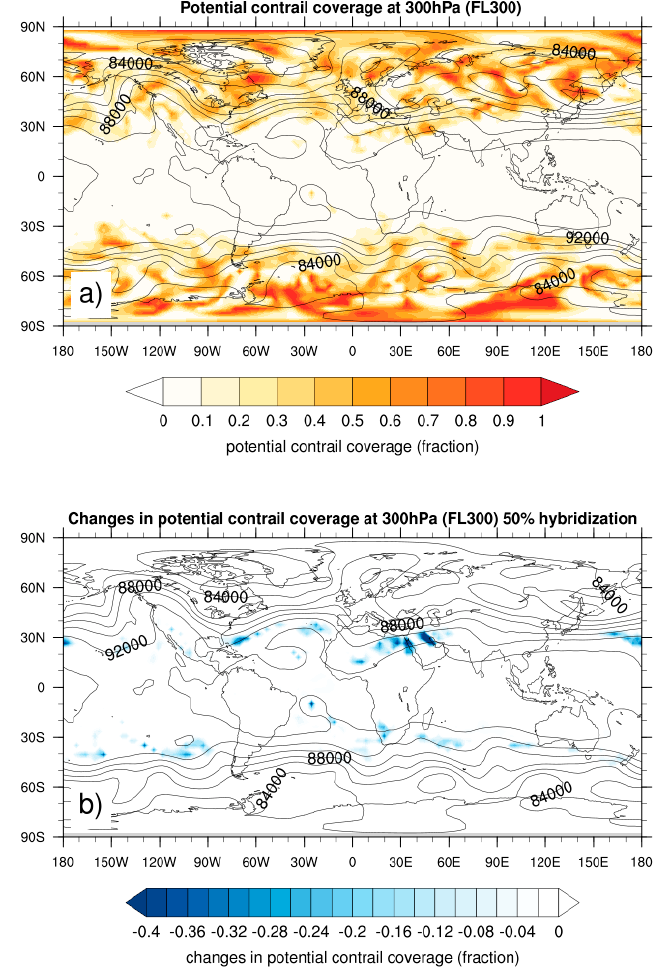
Figure 8. The potential contrail coverage (PCC) (contour) and geopotential (black contour; m 2 s − 2 ) at 300 hPa (FL300) on a specific day: ( a ) conventional aircraft; ( b ) absolute changes caused by HEA with 50% electric power.